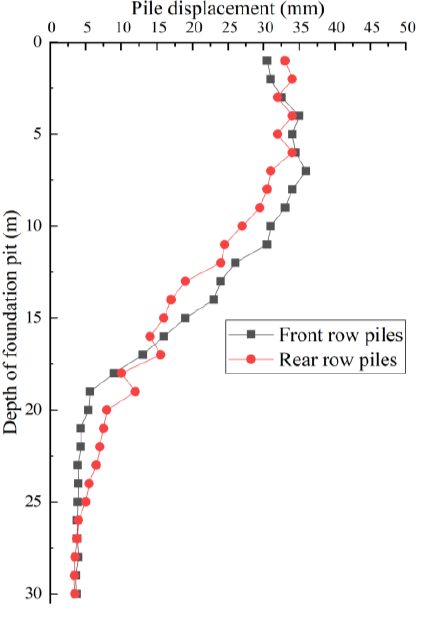
Figure 10. Horizontal displacement of front and rear rows of piles.